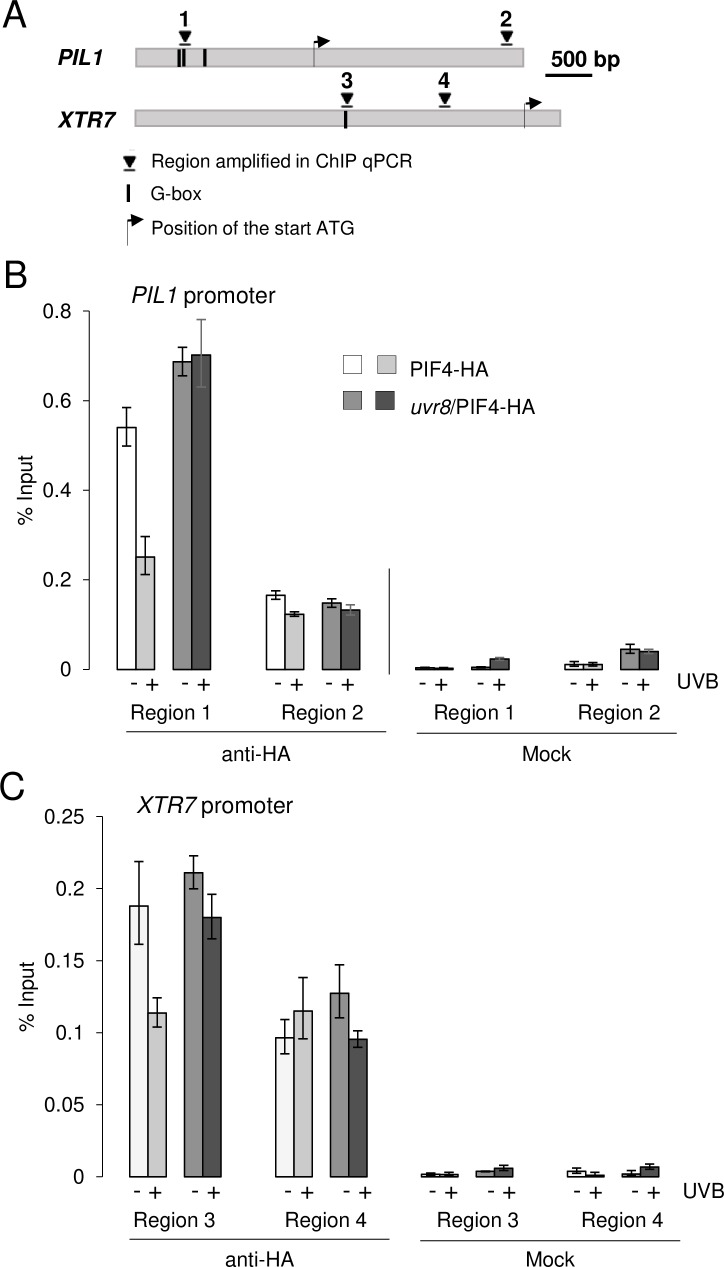
UV-B impairs PIF4 binding to shade marker genes’ promoters in a UVR8-dependent manner.(A) Schematic representation of PIL1 and XTR7 with G-boxes and regions amplified in ChIP-qPCR indicated. (B, C) PIF4-HA chromatin association in Col/ProPIF4:PIF4-3xHA (PIF4-HA) and uvr8-6/ProPIF4:PIF4-3xHA (uvr8/PIF4-HA). Ten-day-old seedlings were grown in long-day conditions under white light and exposed to low R:FR with (+) or without (-) 3-h supplemental narrowband UV-B at ZT3. ChIP-qPCR was performed for (B) PIL1 and (C) XTR7 promoters. ChIP data are presented as the percentage recovered from the total input DNA (% Input). Data shown are representative of three independent biological replicates (see S5A–S5D Fig). Error bars represent SD of three technical replicates. Immunoprecipitated DNA was quantified by qPCR using primers in the promoter regions containing G-boxes (region 1, ProPIL1_-1417; region 3, ProXTR7_-197) or control regions without G-boxes (region 2, ProPIL1_+1816; region 4, ProXTR7_-664).